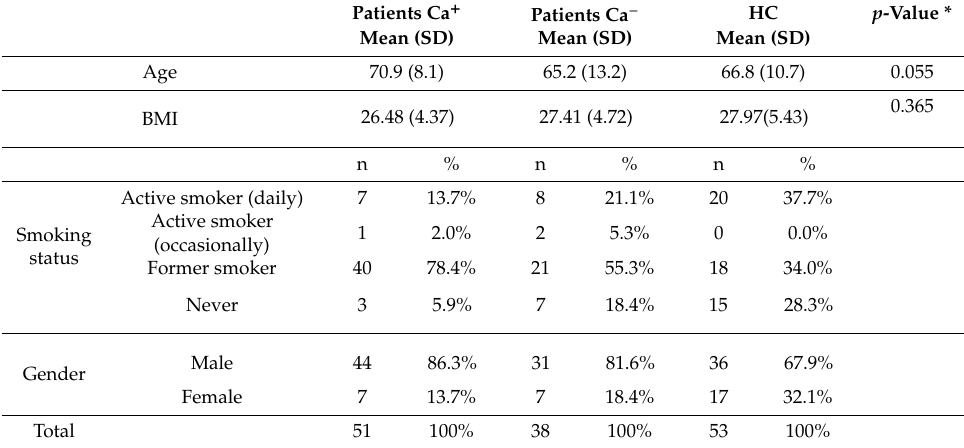
Table 1. Characteristics of the study